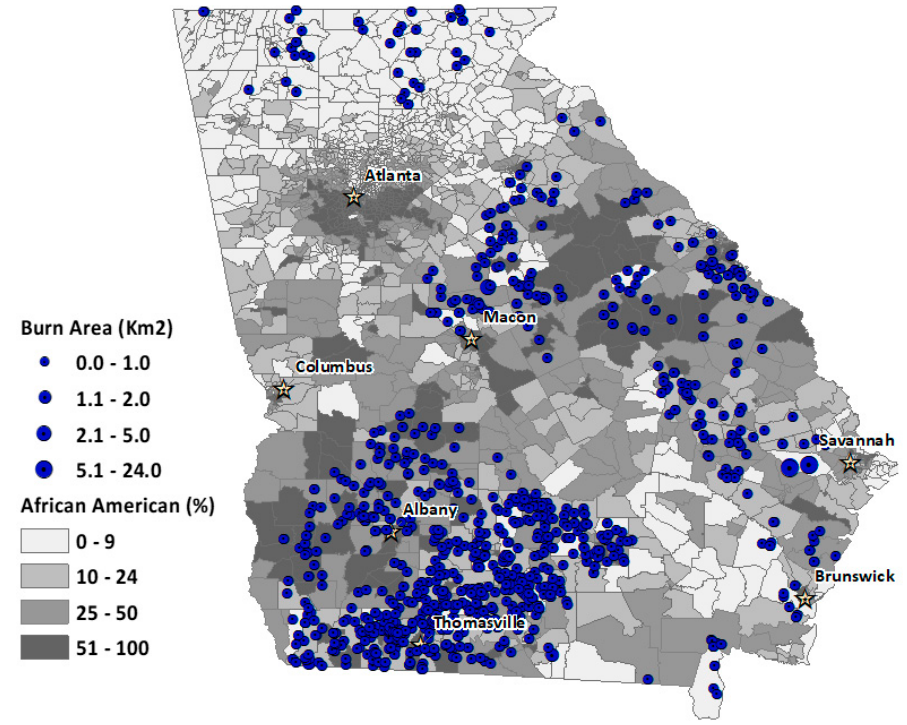
Figure 6. Spatial distribution of burn permits for non-industrial private landowner (NIPL) exceedance days, overlaid with percent African American population for Georgia census tracts. Circles denote the relative burn area size for each